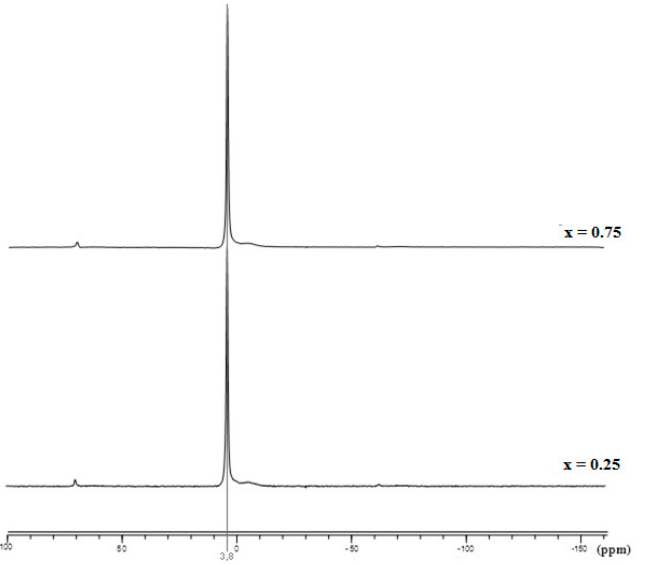
Figure 3. Infrared spectra of synthesized Ca 10 − x K x (PO 4 ) 6 F (2 − 2 x ) (OH) x for x = 0.25 and x = 0.75.